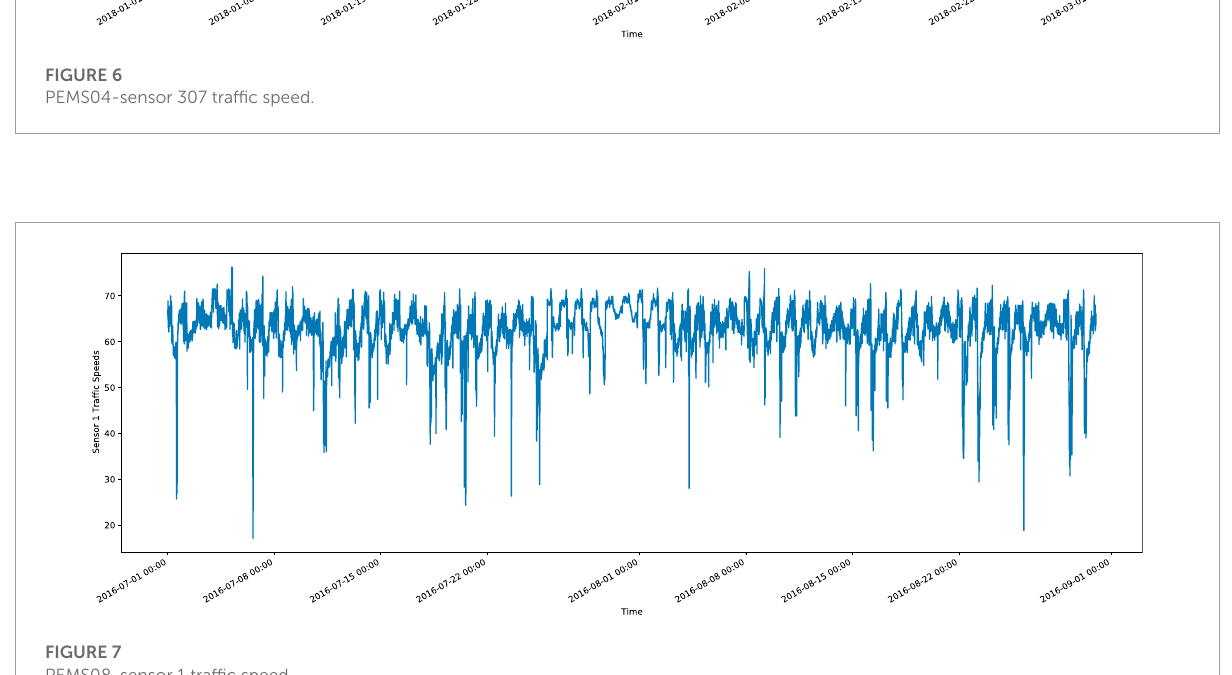
FIGURE 7 PEMS08-sensor 1 traffic